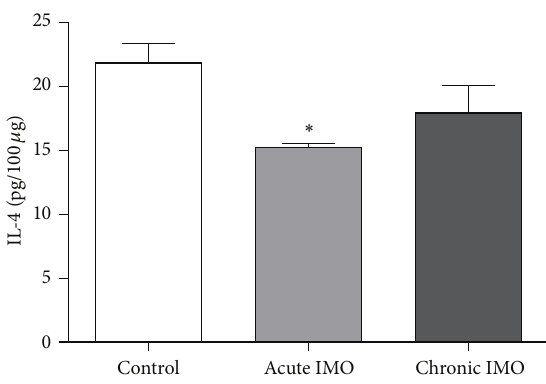
Figure 2: Mean ( ± SEM) IL-4 protein level in the LC of the acutely and chronically stressed and control rats. Expression of IL-4 was significantly decreased in the acutely stressed group. ( 𝑛 = 6 per group) ∗ 𝑃 < 0.05 versus control; ANOVA.